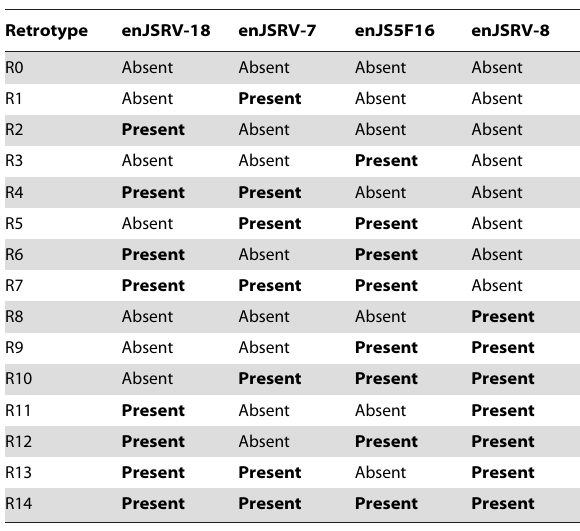
Table 1. The retrotype classification defined in [17] and based on the combination of the four common retroviral insertions in a population is shown in the Table, ‘present’ is highlighted in bold style